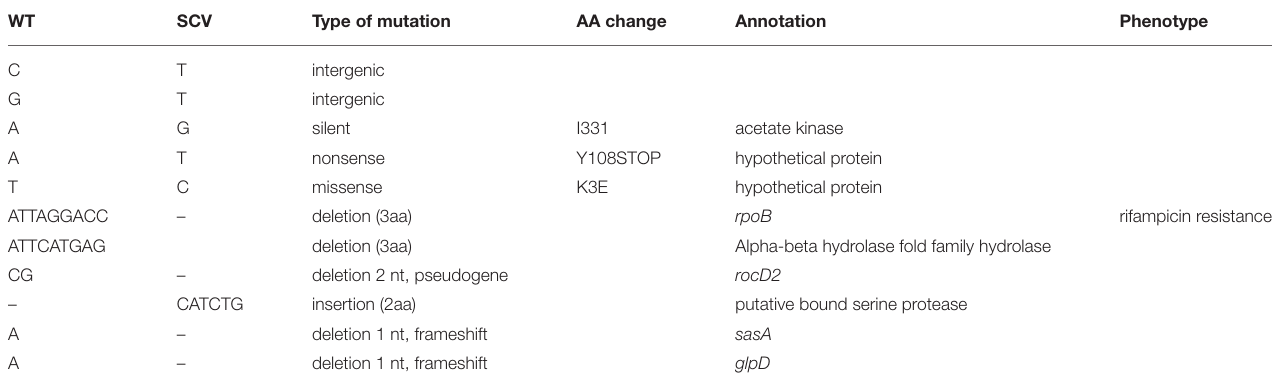
TABLE 2 | Nucleotide variations observed between initial, WT, and recurrent, stable SCV strains.